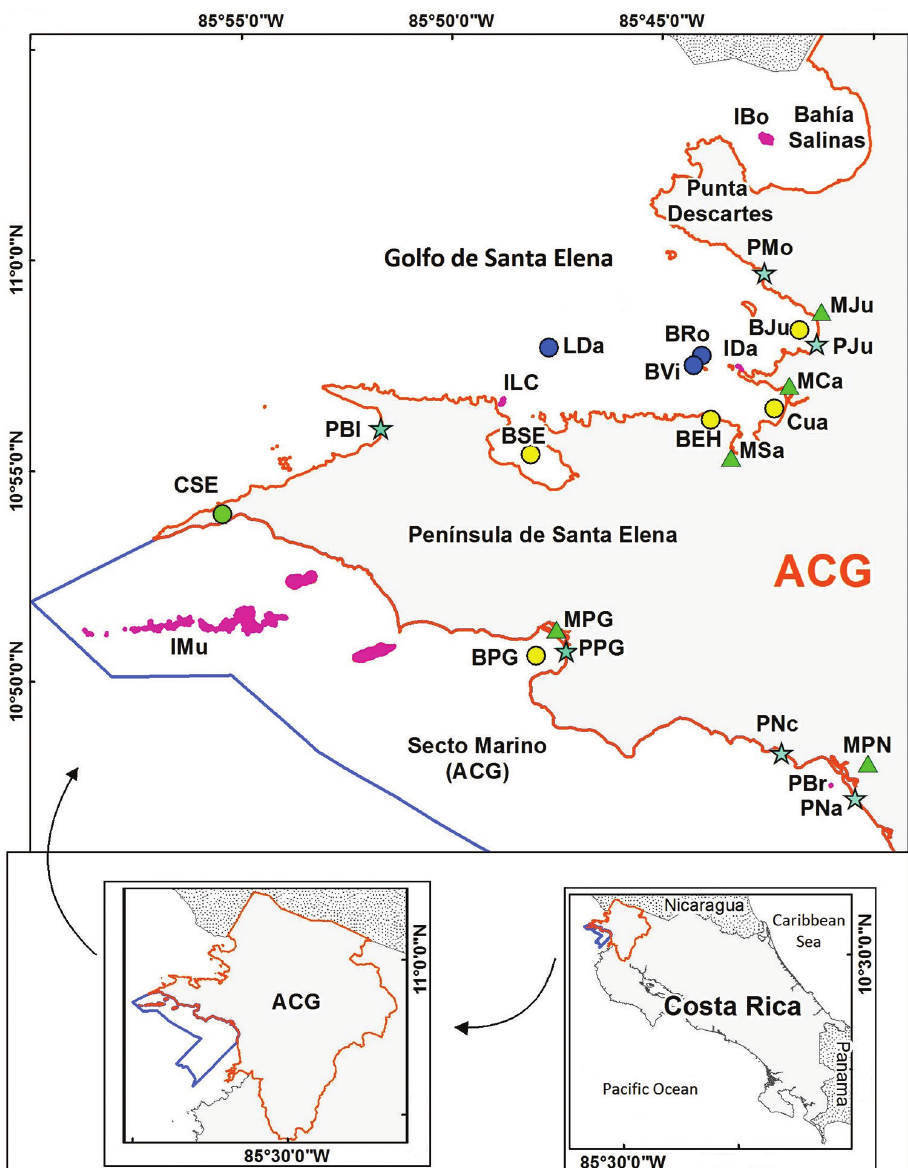
Figure 1. Map of the Área de Conservación Guanacaste (ACG) in the northern Pacific coast of Costa Rica with indication of the sites mentioned in the text. See Table 2 for the codes of the sites. Stars = beaches, triangle = mangrove forests, circle = bays; green = protected area; blue circles = shoals. nesting site in the country of the frigate bird, Fregata magnificens , is on one of the nearby islands, Isla Bolaños, in Bahía Salinas (Alvarado-Quesada 2006). An outstand- ing oceanographic feature of the region is the seasonal upwelling (the Papagayo